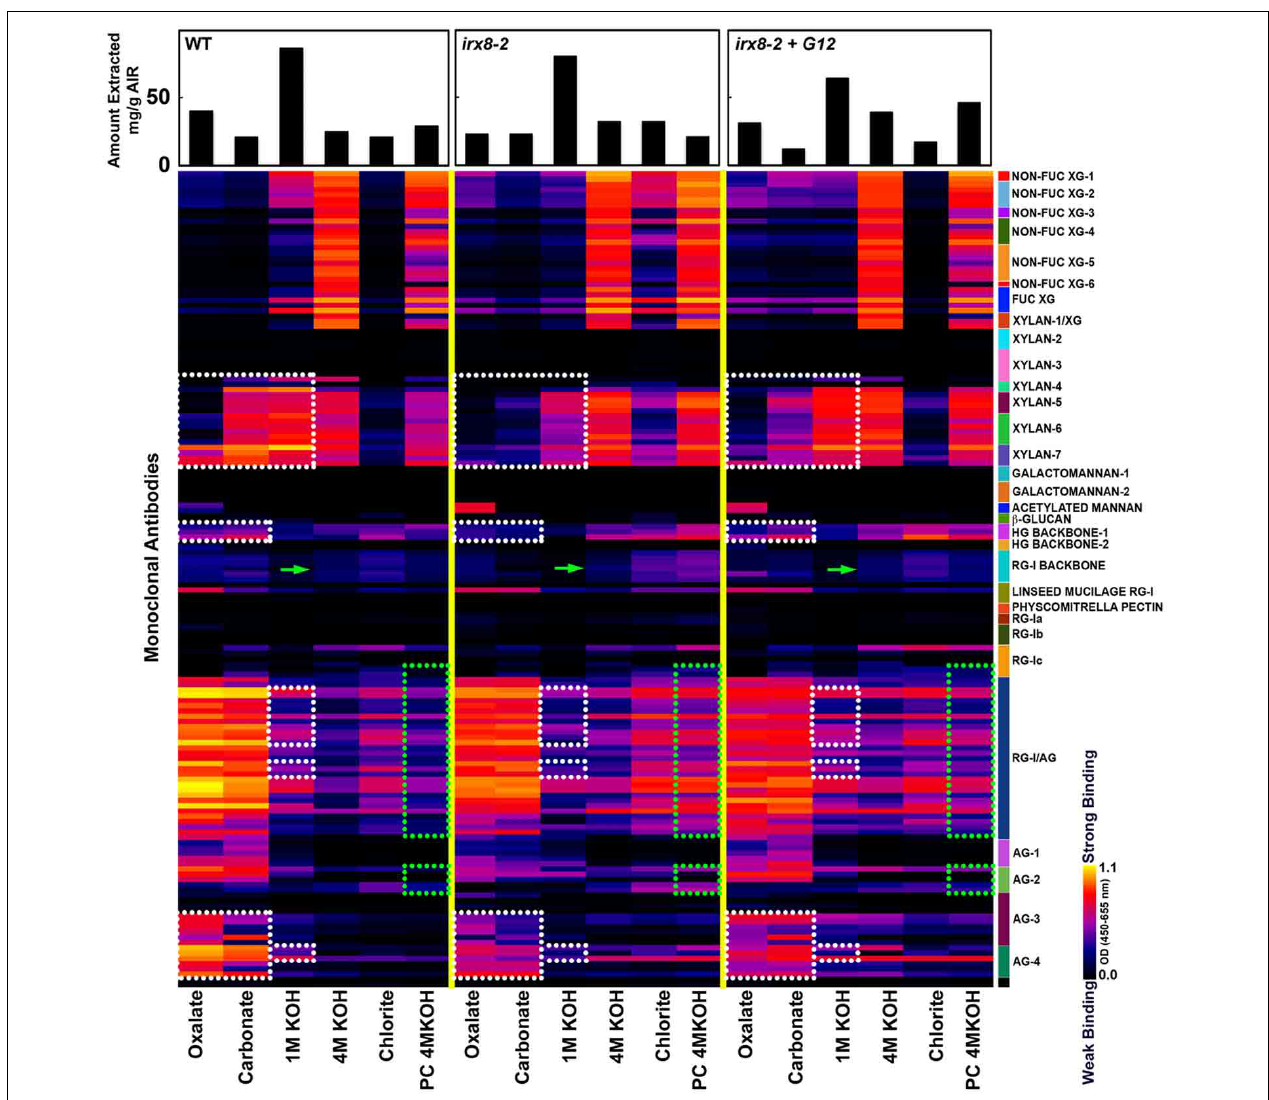
FIGURE 7 | Glycome profiling of cell walls prepared from 7/8-week-old stem tissues of irx8-2 , irx8-2 + GAUT12 , and wild-type (WT) plants. Sequential cell wall extracts were made from respective cell wall preparations using ammonium oxalate (oxalate), sodium carbonate, potassium hydroxide (1M and 4M KOH), acidified chlorite and potassium hydroxide post chlorite (PC4MKOH). The resulting extracts were screened by ELISA using a suite of 155 monoclonal antibodies (mAbs) directed against diverse epitopes present on major plant cell wall glycans (See Supplemental Table S2). The ELISA binding responses are